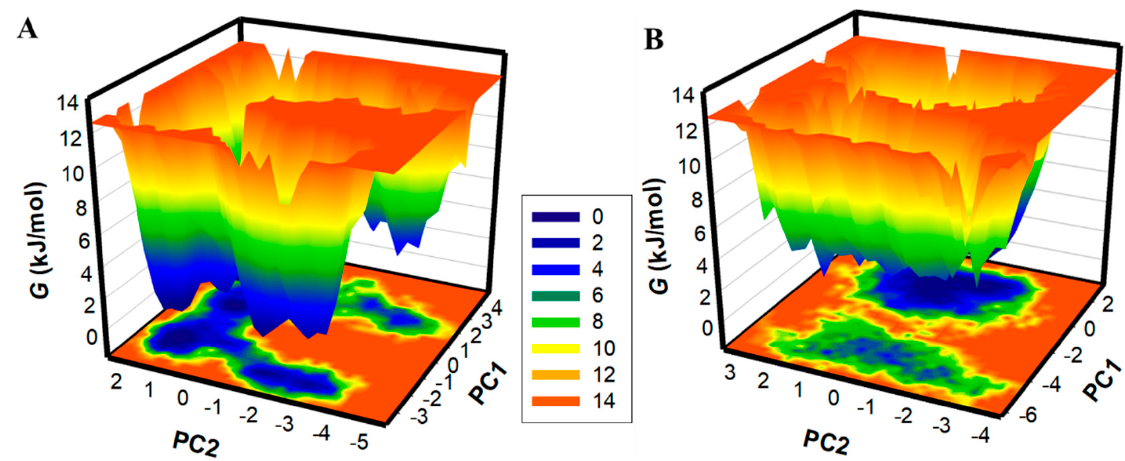
Figure 7. The FEL plots for ( A ) PKM2 and ( B ) PKM2-Tuberosin complex.